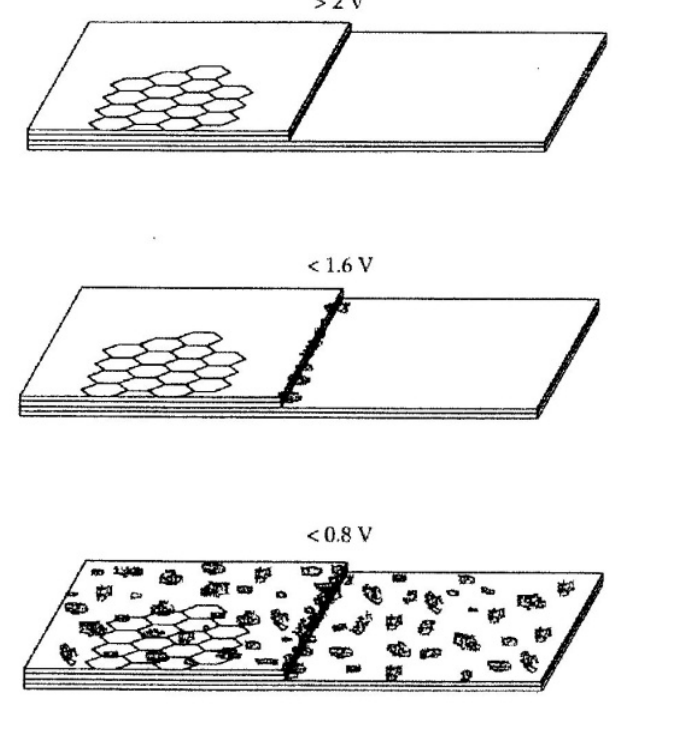
Figure 7. Schematic description of the step-wise formation of SEI on graphite surface based on AFM results. (reproduced from Figure 10 in [22] with the permission from the Electrochemical